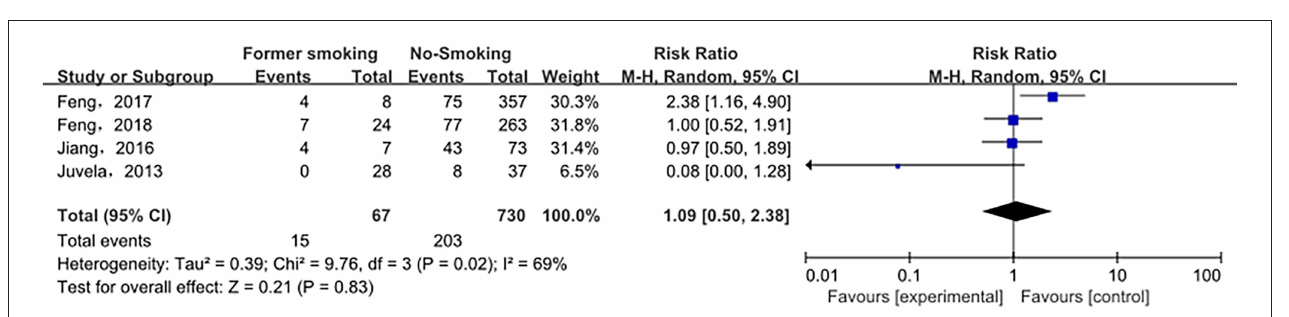
FIGURE 3 | A Forest plot of the former smoking and non-smoking groups.